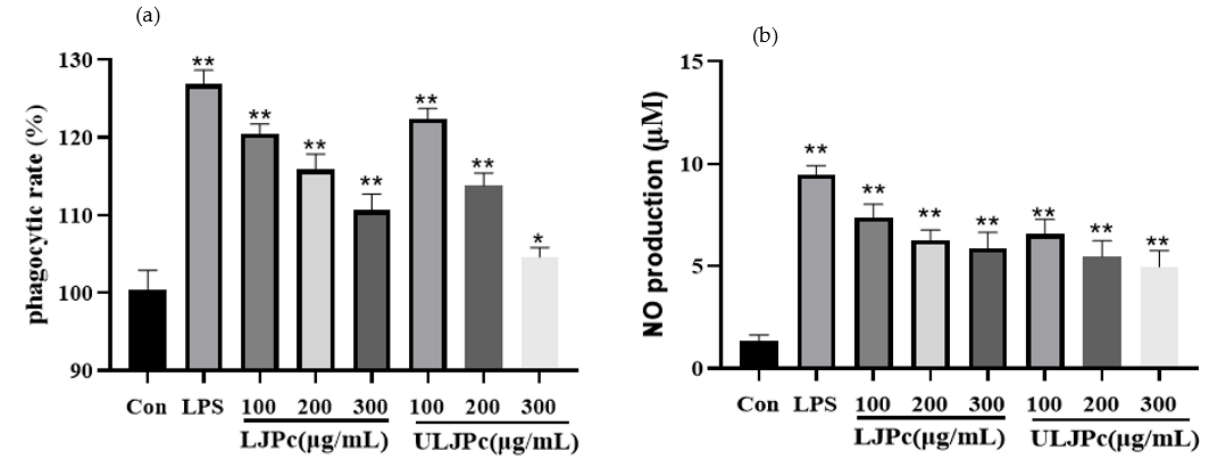
Figure 8. Effects of LJP and ULJP on the morphology of RAW264.7 macrophages. (* p < 0.05; ** p < 0.01). ( a ) phagocytic rate (%) ( b ) NO production μ M.